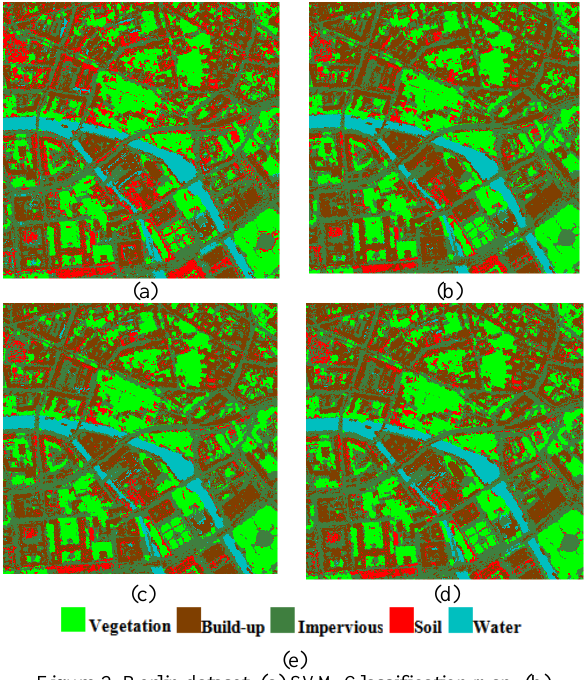
Figure 2. Berlin dataset: (a) SVM Classification map, (b) MMSF Classification map, (c) MSF-SVM Classification map (d) reference map and (e) the legend.